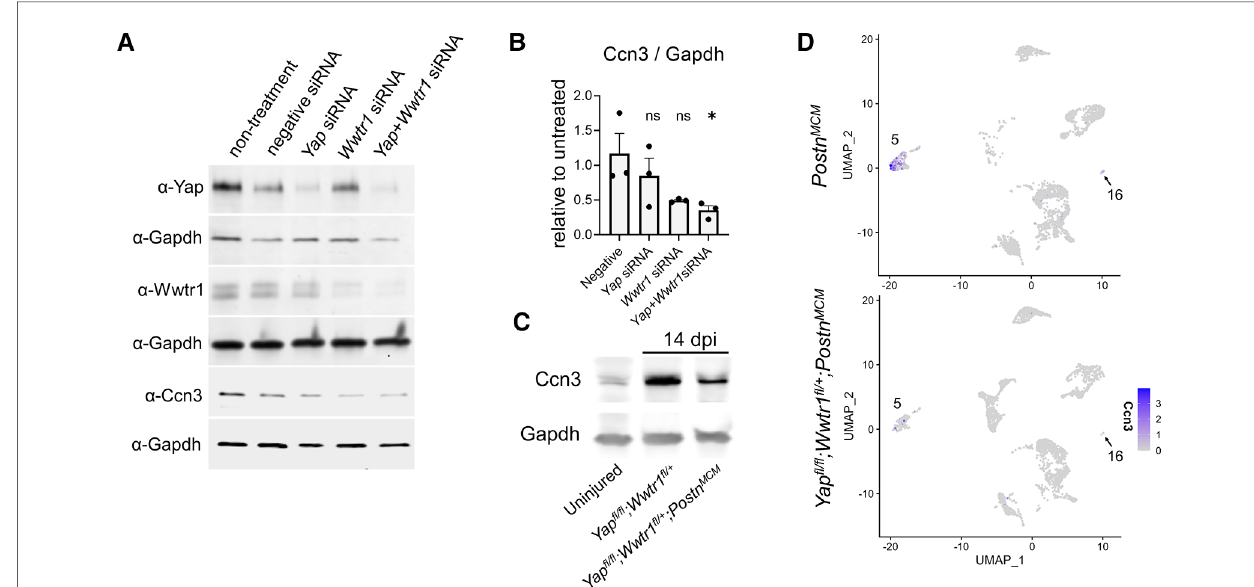
FIGURE 6 Ccn3 abundance decreases with depletion of Yap/Wwtr1. ( A ) Western blots depicting protein abundance of Yap, Wwtr1, or Ccn3 following siRNA treatment in cultured neonatal rat cardiac fi broblasts with Gapdh loading controls. ( B ) Quanti fi cation of Ccn3 protein from neonatal rat cardiac fi broblasts following siRNA, normalized to non-treated samples. n =3 biological replicates per group. Each replicate consisted of cells from independent litters. One-way ANOVA comparing experimental groups to negative siRNA control by Dunnett ’ s test. ( C ) Western blot depicting Ccn3 abundance in left ventricles of uninjured and 14 dpi left ventricles. ( D ) Feature plot illustrating the abundance of Ccn3 expressing cells by UMI within clusters 5 and 16. Ns, not signi fi cant and * P